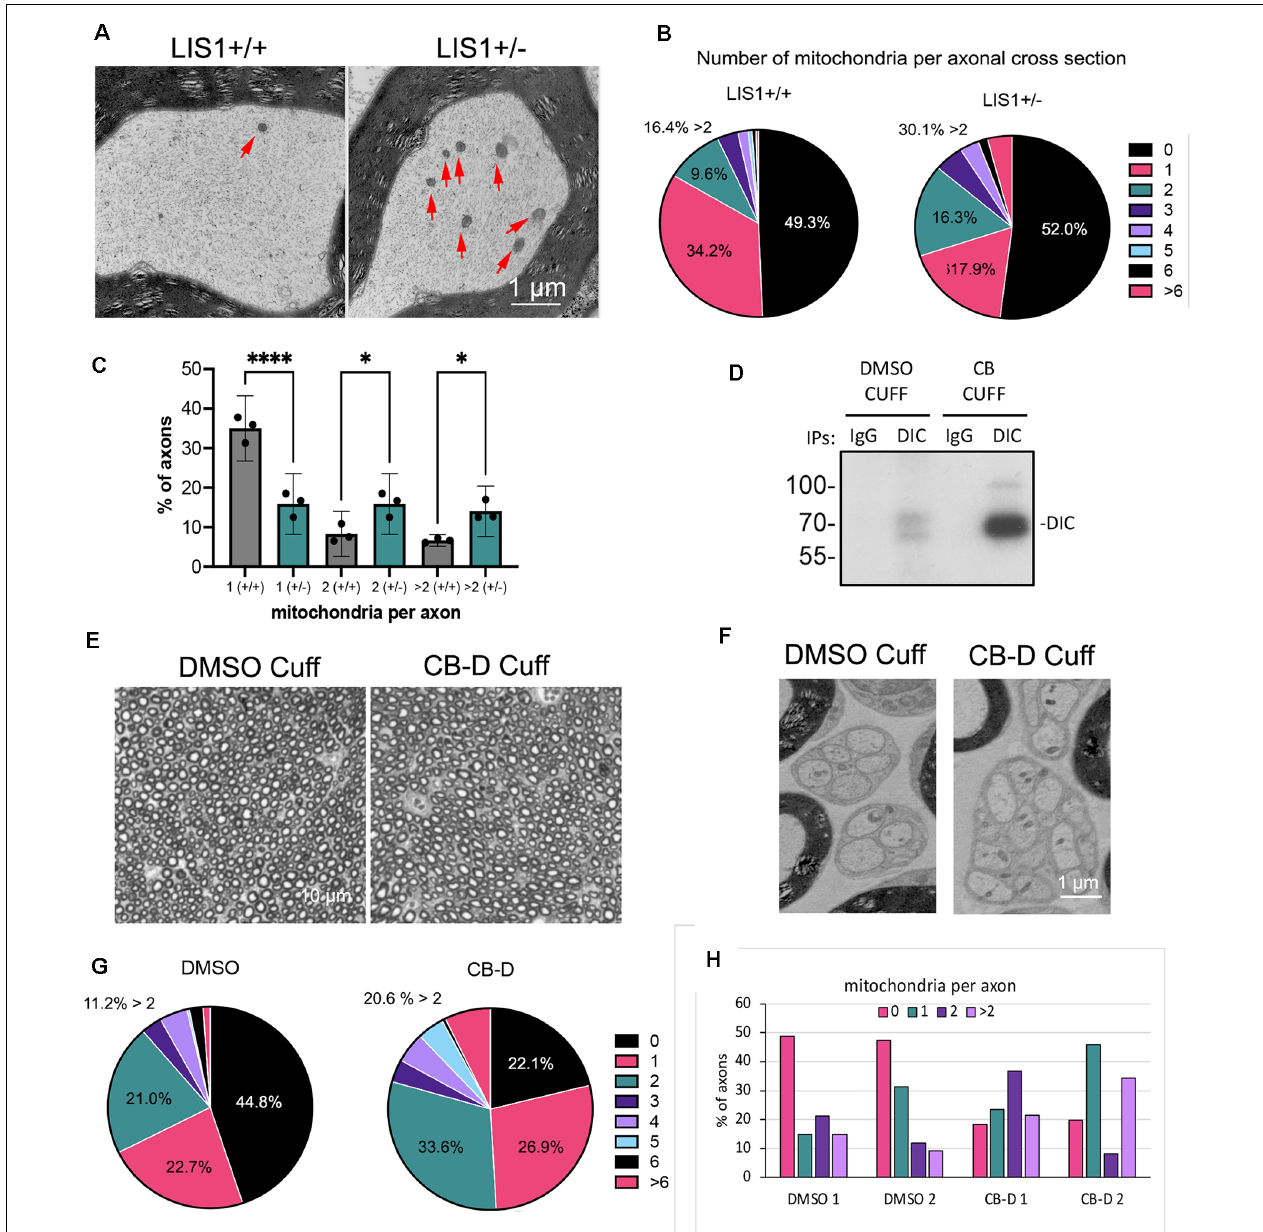
FIGURE 1 | More mitochondria are observed in sciatic nerve axonal cross-section from LIS1 +/- mice or rat nerves exposed to Ciliobrevin-D. (A) Representative electron micrographs of cross-sections of myelinated axons in sciatic nerves from adult WT LIS1 and LIS1 +/- mice at mid-thigh. Red arrows point to mitochondria within the axoplasm. EM images from three different mice of each genotype were analyzed for numbers of mitochondria per axon. (B) The pie graphs show the percentage of all axonal cross-sections that contained the indicated number of mitochondria (1- >6). A total of 676 LIS1 +/+ axons and 405 +/- axons from three mice of each genotype were included, approximately equal numbers per animal. The variation is not because of degeneration but simply a matter of number of axons in each EM micrograph, which was variable. (C) The bar graph shows the mean of data (+/- 95% CI) from the three mice in each category. Axons with 0 mitochondria were excluded because the numbers were large and the differences in one mitochondrion, two mitochondria, or >2 mitochondria were less clear. Significance determined by ANOVA using Holm-Šídák’s multiple comparisons test. ∗∗∗∗ p < 0.0001; ∗ p > 0.05. (D) Ciliobrevin-D (CB-D) was used to inhibit dynein by placing PEVA nerve cuffs impregnated with the compound around adult rat sciatic nerve in mid-thigh. After 48 h dynein had accumulated under a CB-D cuff but not a DMSO control cuff as seen in the IP-Western for dynein intermediate chain (DIC). (E) Brightfield image of nerve sections stained for EM shows that the nerves look normal and have similar numbers of axons. (F) Unmyelinated axons in Remak bundles also appeared healthy in both DMSO and CB-D treated nerves. (G) The pie graphs show the percentage of all axonal cross-sections that contained the indicated number of mitochondria (1- >6). 150 DMSO axons and 105 CB-D axons from two rats were included. (H) The bar graph shows the percentage with 0, 1, 2 or >2 mitochondria for each DMSO treated nerve and each CB-D treated nerve.